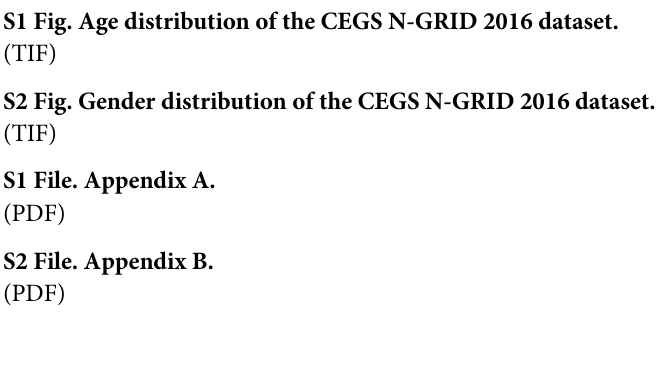
S1 Fig. Age distribution of the CEGS N-GRID 2016 dataset. S2 Fig. Gender distribution of the CEGS N-GRID 2016